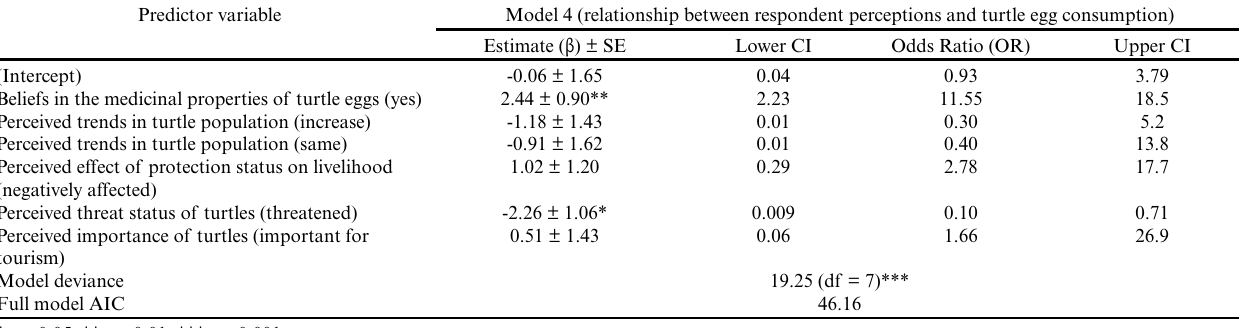
Table 7 . Results of the logistic regression model that explains the influence of respondents’ perceptions on turtle egg consumption (n = 44). Values indicate the coefficient estimates ( β ) ± standard errors of estimates (SE), model deviance and the associated degrees of freedom (df), and